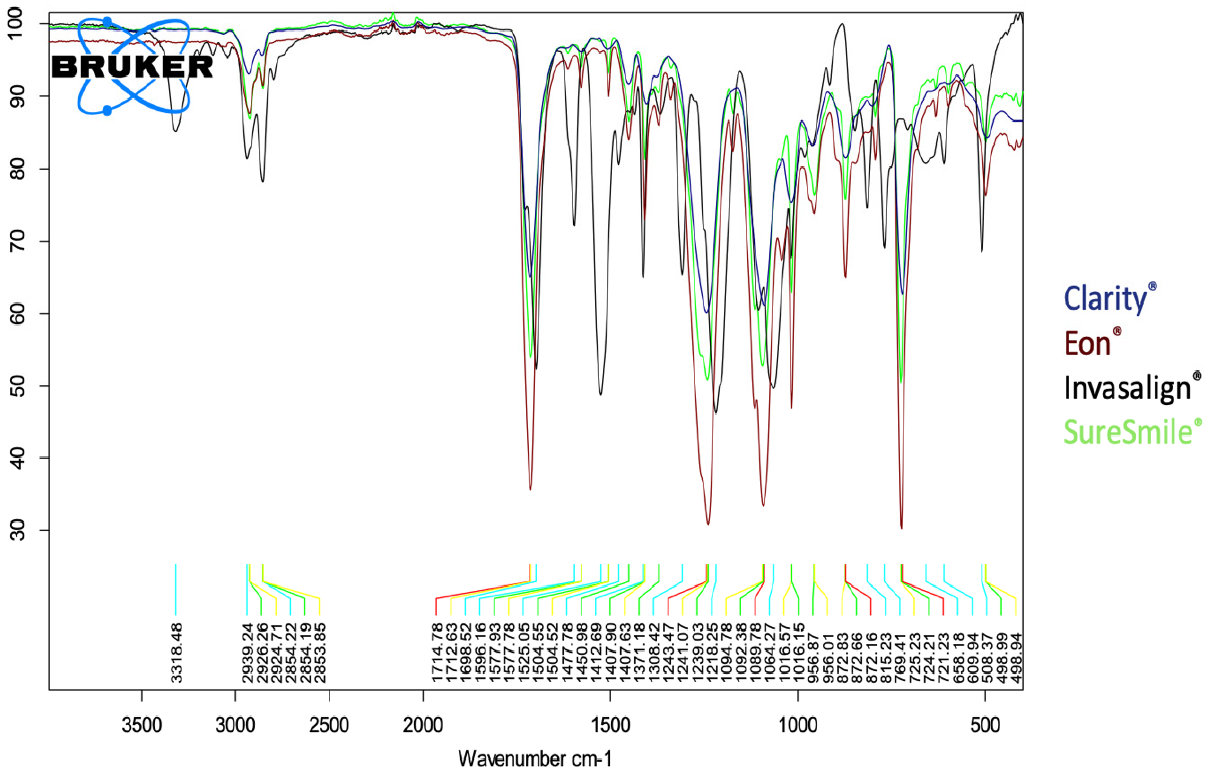
Figure 2. Superimposition of Fourier transform infrared spectroscopy of the four included systems .